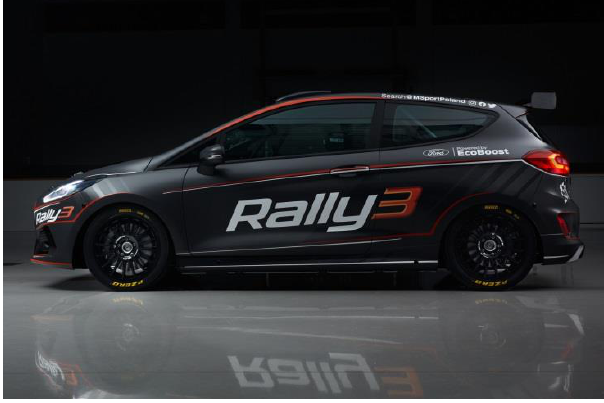
Fig. 3. M-Sport Poland Ford Fiesta ST Rally3